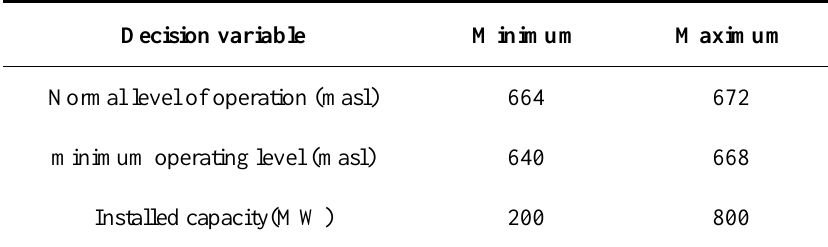
Table1. The scope of decision